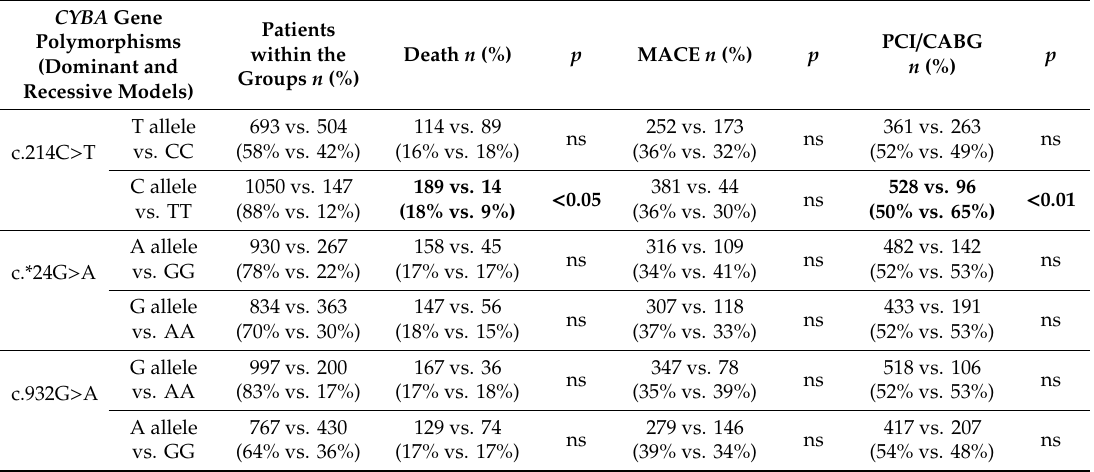
Table 2. Prevalence of the evaluated endpoints in the dominant and the recessive model subgroups with the log-rank test p -value.